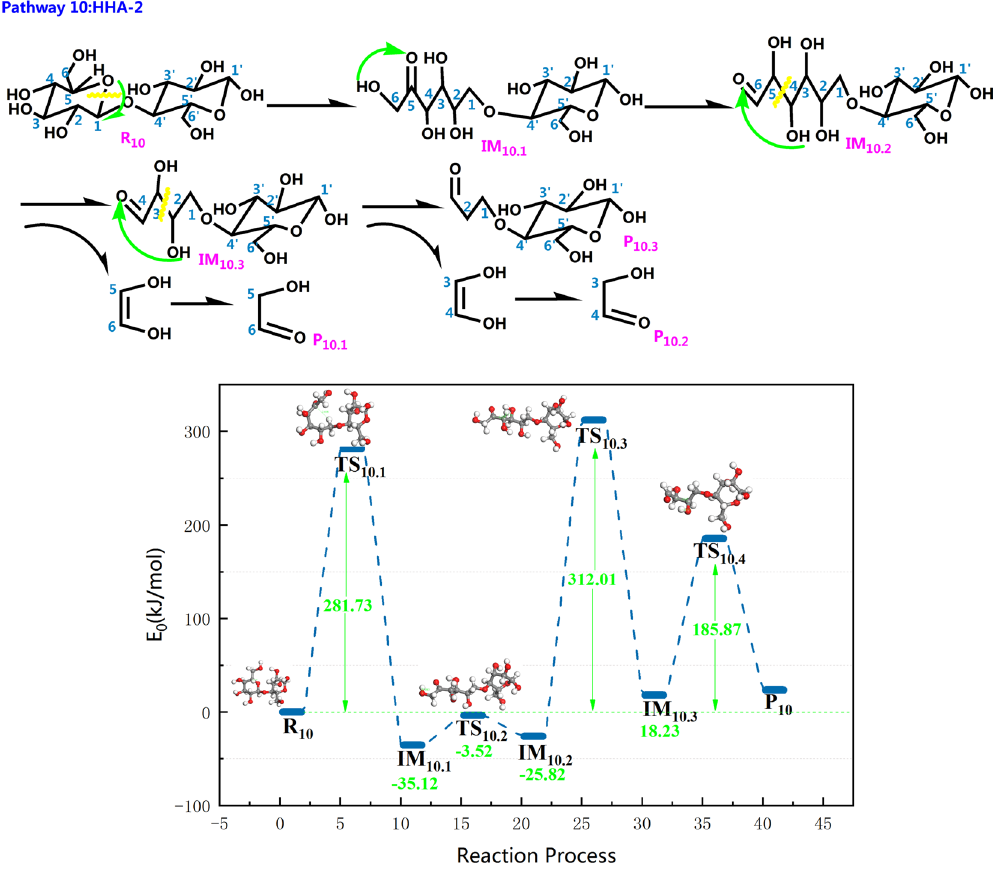
Figure 15. Reaction step and reaction energy barrier of pathway